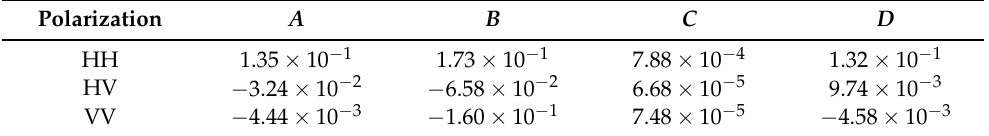
Table 3. Values of the parameters of the water cloud model (WCM) calibrated with all available in-situ measurements of green area index (GAI) and volumetric surface soil moisture, V m , and their corresponding L-band SAR backscattering coefficients and incidence angles.